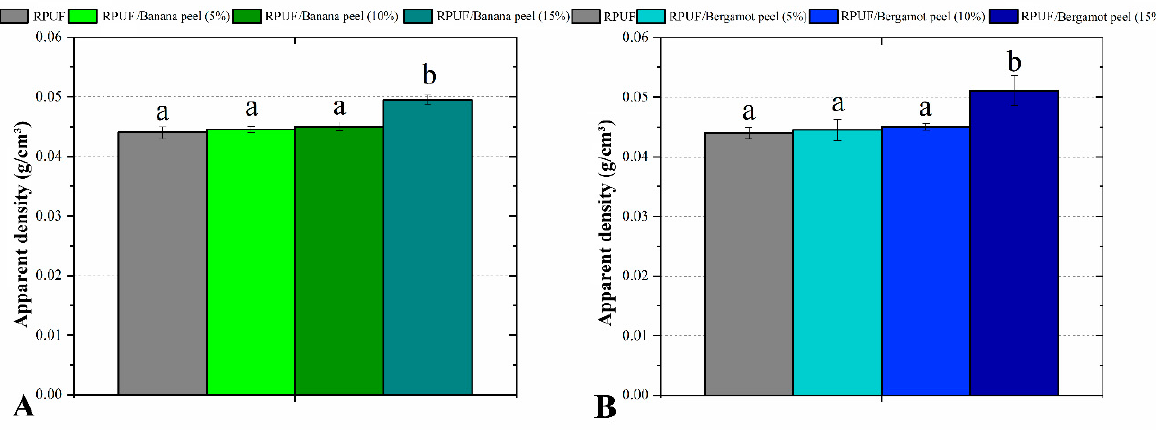
Figure 6. Apparent density of the studied RPUF with Banana peels ( A ) and Bergamot peels ( B ). RPUF is the neat rigid polyurethane foam and filler type, and filler content is the numbers after the bars and between parentheses, respectively. Different letters represent statistically different means.